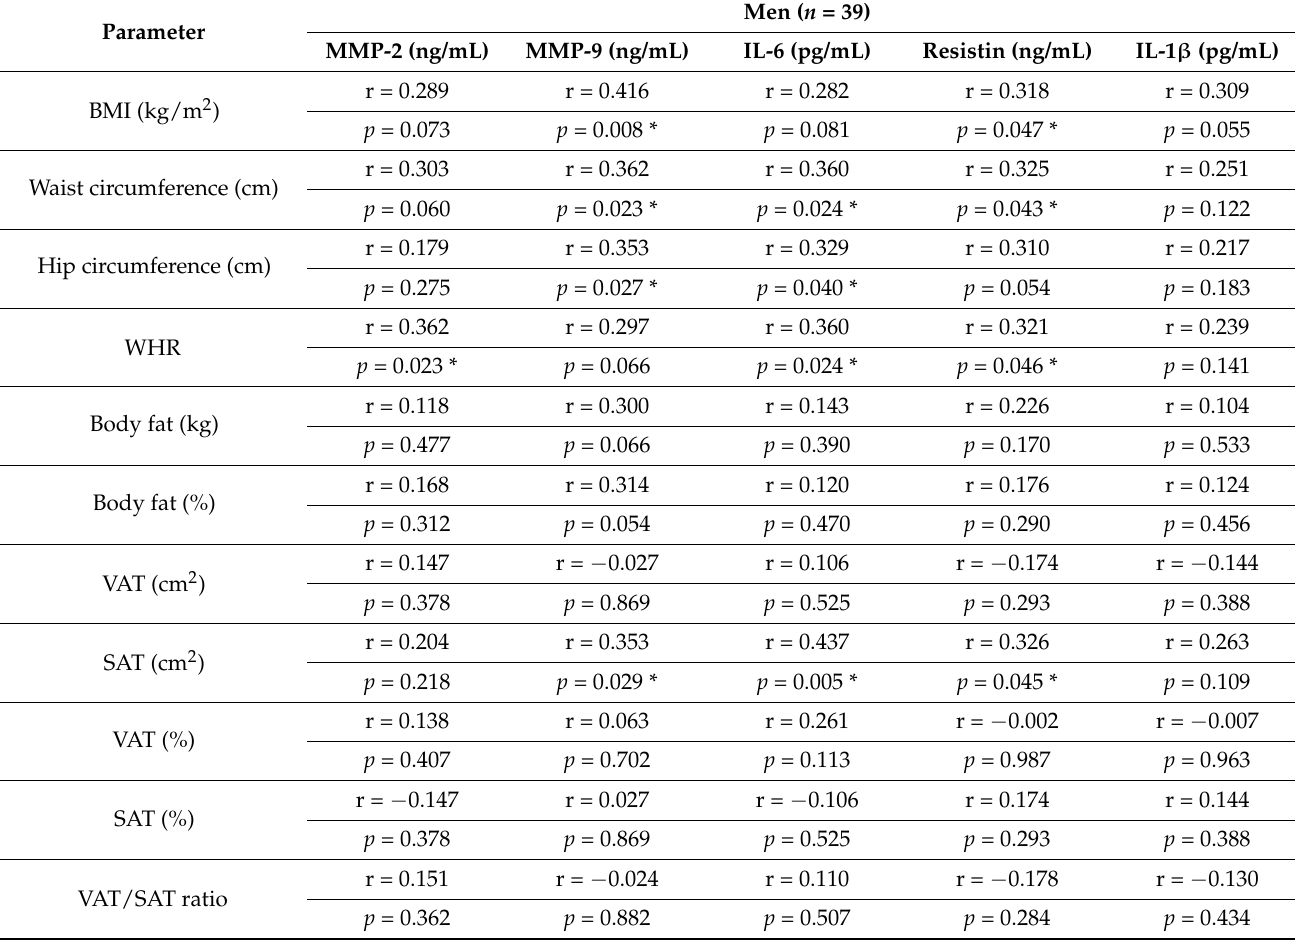
Table 4. Correlations between selected anthropometric/body composition parameters and the concentrations of cytokines/adipokines in the saliva of men from the study and control